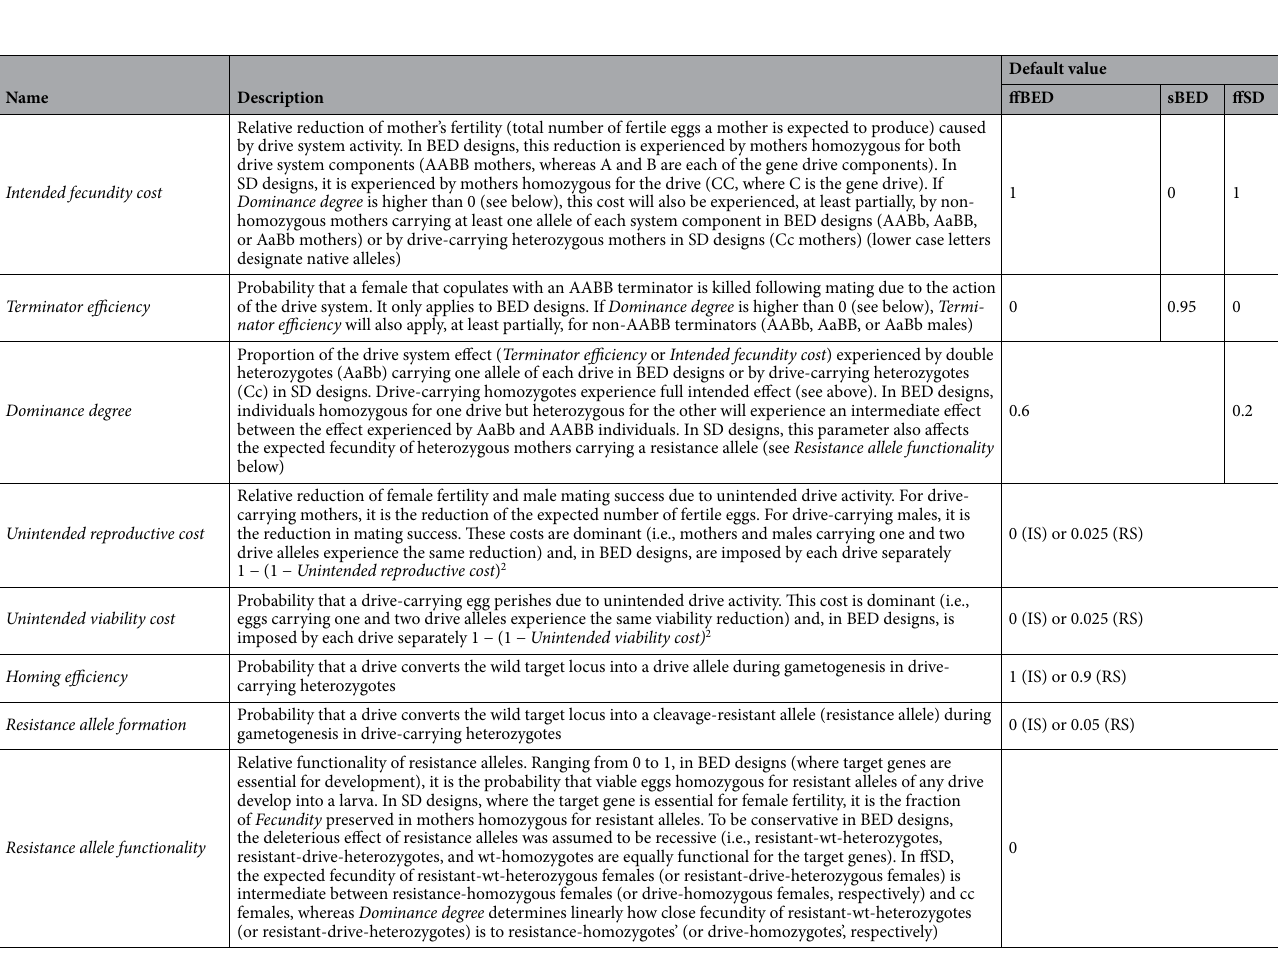
Figure 3 and Fig. S1 summarize the performance of the three gene drive designs with ideal and reference drive activity. Using the ideal drive parameters, we observed a fast and complete elimination rate for all three designs. However, using reference drive parameters (i.e. assuming imperfect drive activity), performance differed between designs. Overall, ffBED showed the worst performance. It was not able to eliminate the target population in any simulation, although it reduced the popu- lation by ~ 51% in 16 generations; and genetic load stabilized at around 0.84 after generation 14. Irrespective of